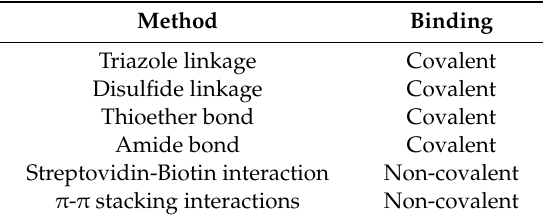
Table 2. Chemical methods of extracellular vesicle (EV) surface cross-linking.